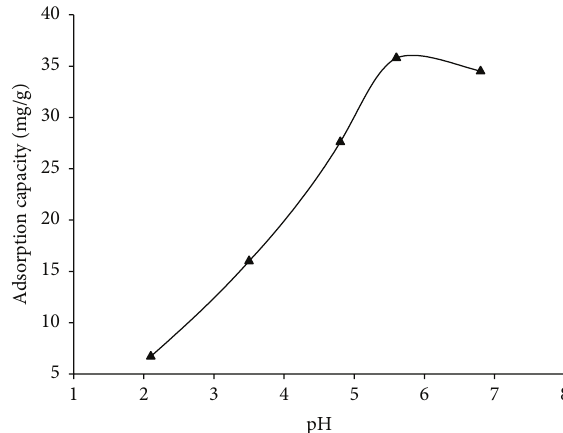
Figure 4: SEM image of lead ion loaded CCRWSD.